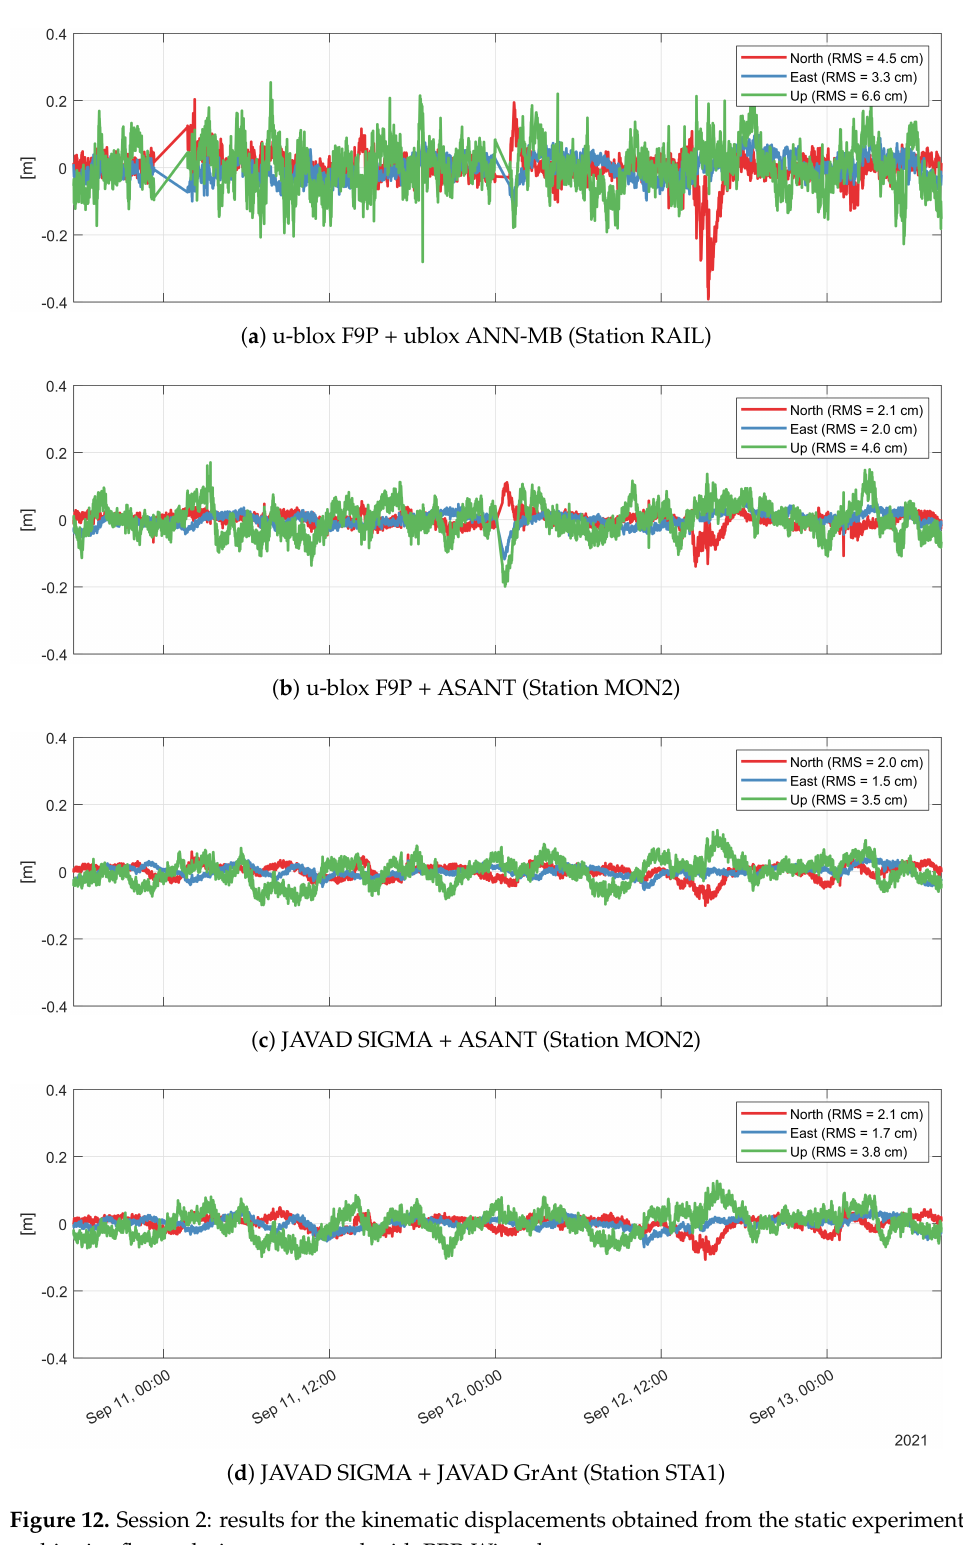
Figure 12. Session 2: results for the kinematic displacements obtained from the static experiments— ambiguity-float solutions computed with